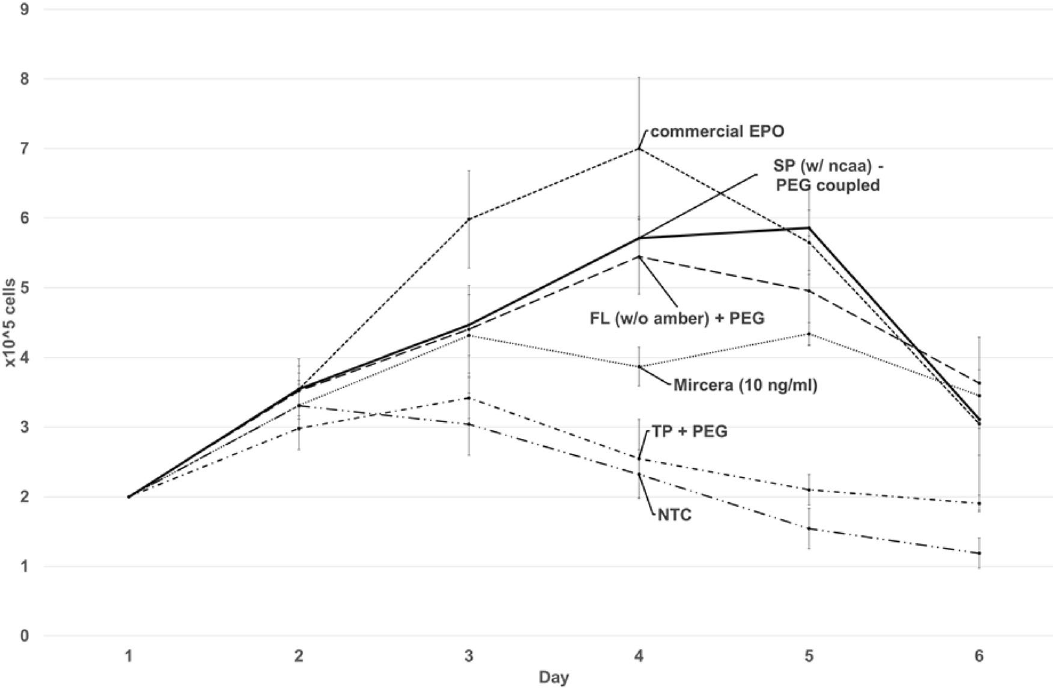
Figure 3. Cell-based activity assay of PEG-modified and non-modified cell-free synthesized EPO. Growth curves of TF-1 cell-line supplemented with PEG-modified EPO (continuous line), non-modified EPO (dashed line), termination product (dashed-single-dot line) cell-free no template control (NTC, dashed-double-dot line), commercial EPO (dashed line) and commercial Mircera® (grey dashed line). Concentrations of cell-free synthesized EPO variants were determined by TCA precipitation. 10 ng/mL of each sample was added to the TF-1 cells cultured in a 24-well-plate. Cells were counted for 6 days. Data are presented as the standard deviation of three independent experiments measured in duplicates (n =